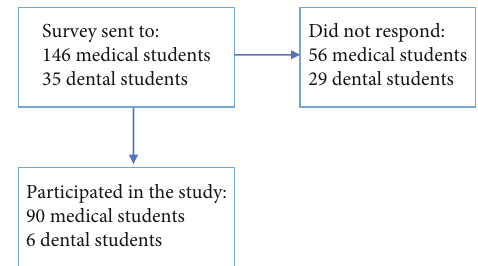
Figure 1: Flow chart of